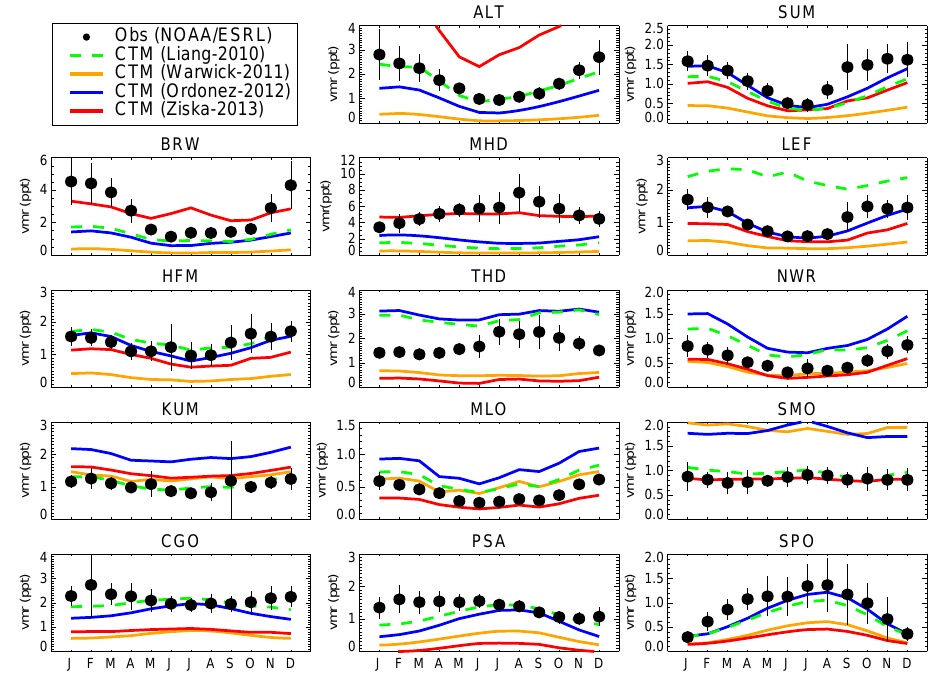
Fig. 5. Comparison of observed monthly mean CHBr 3 mixing ratio (ppt) at 14 NOAA/ESRL ground stations with output from TOMCAT runs S Liang (Liang-2010 emissions), S Warwick (Warwick-2011 emissions), S Ordonez (Ordóñez-2012 emissions) and S Ziska (Ziska-2013 emis- sions). The vertical bars denote ± 1 standard deviation on the observed mean (see text for